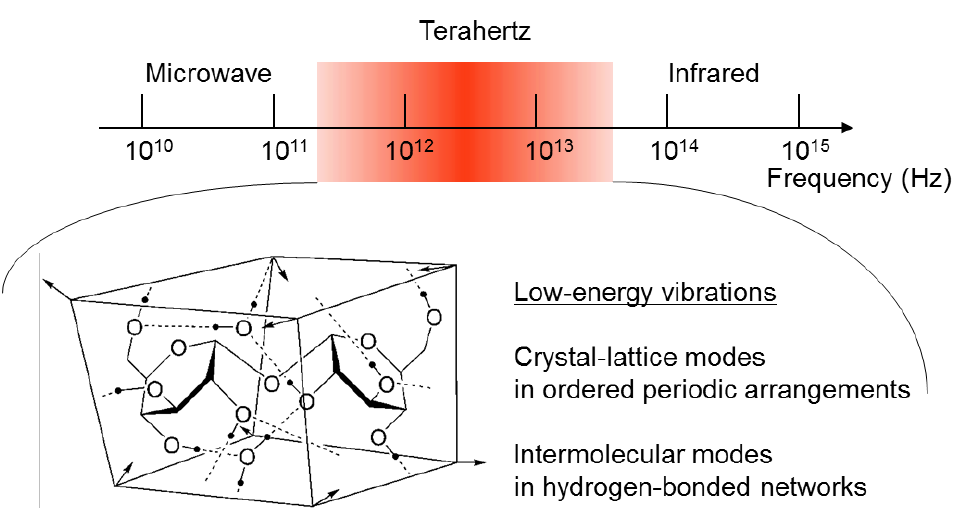
Figure 1. Low-energy vibrational modes in the terahertz (THz)